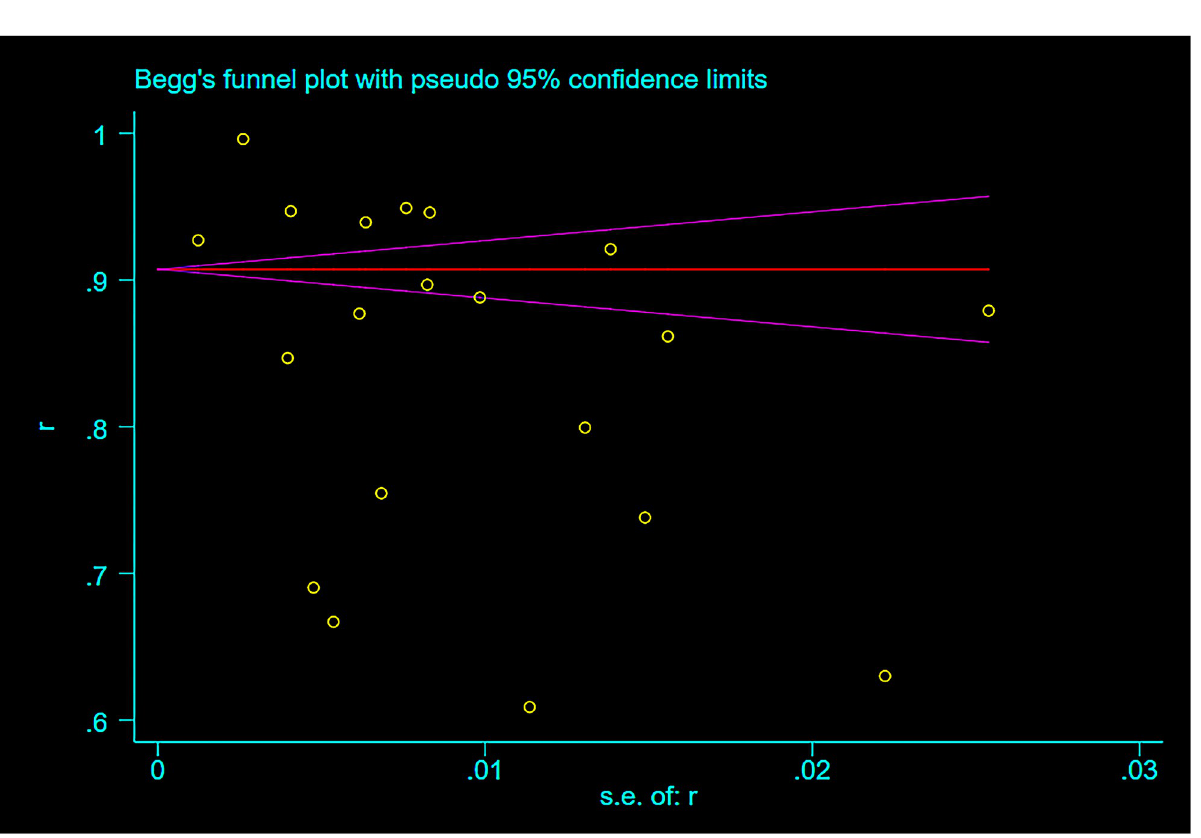
Fig 6. Begg’s funnel plot checking the publication bias of proportion of positive attitudes about COVID-19 among study subjects.